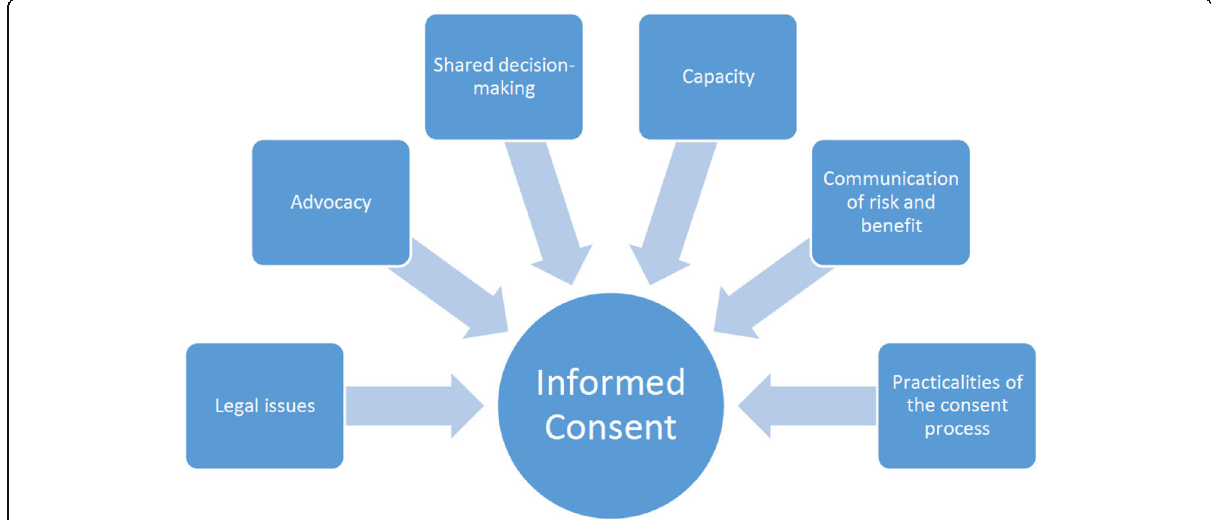
Fig. 1 Considerations to take account of when obtaining consent (reproduced from the Society and College of Radiographers, with their permission)